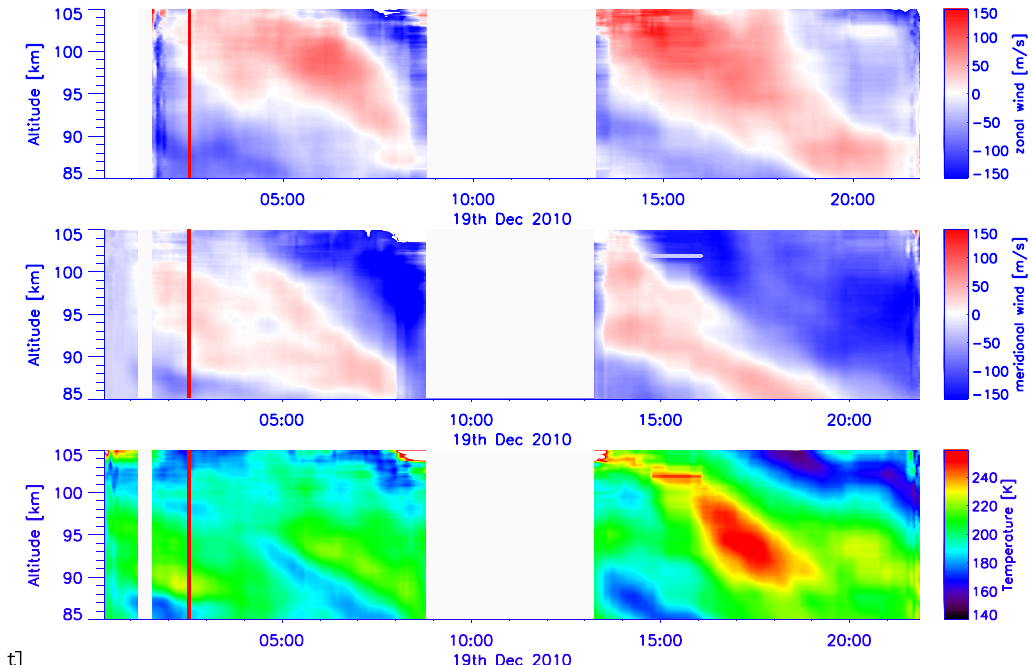
Fig. 4. Zonal (upper panel) and meridional (middle panel) winds and temperatures (lower panel) as measured by the Alomar Na-lidar on 19 December 2010. The blank areas on the plots mark the periods where no data were available. With red vertical line launch time of the third ECOMA rocket is marked.